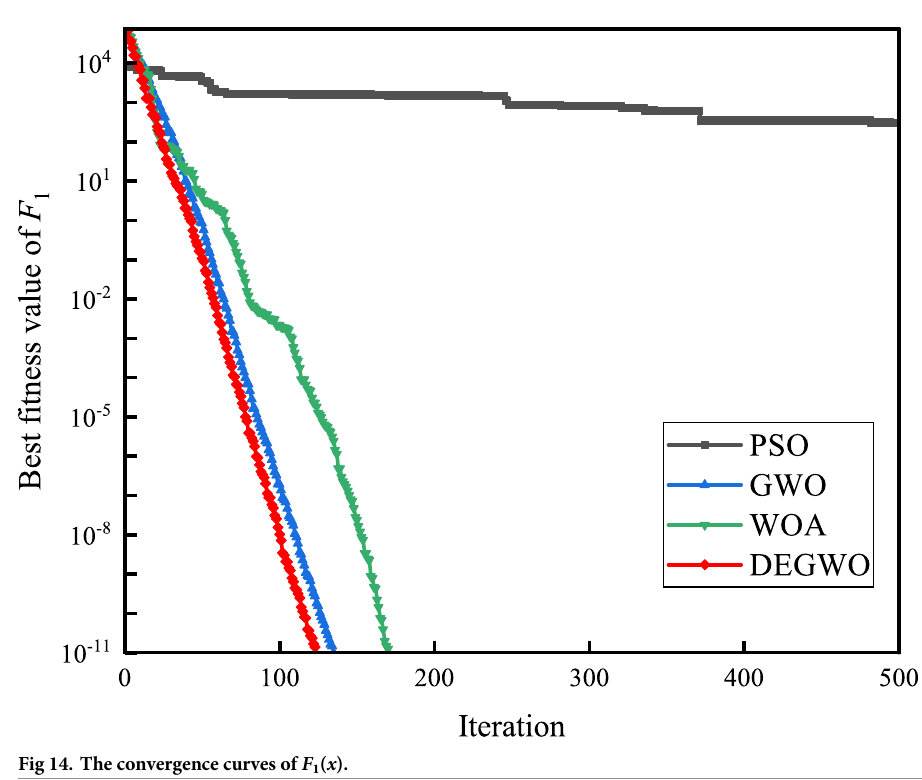
Fig 14. The convergence curves of F 1 ( x ).